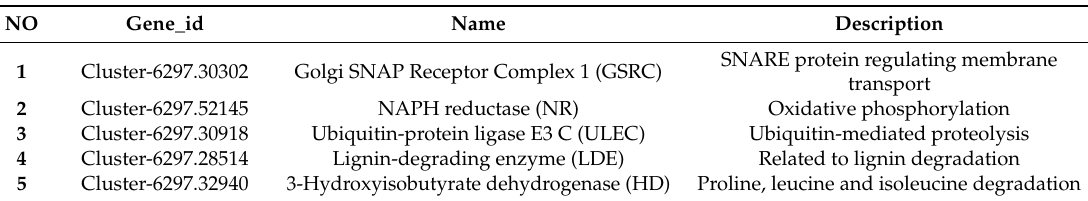
Table 1. Significantly upregulated genes.